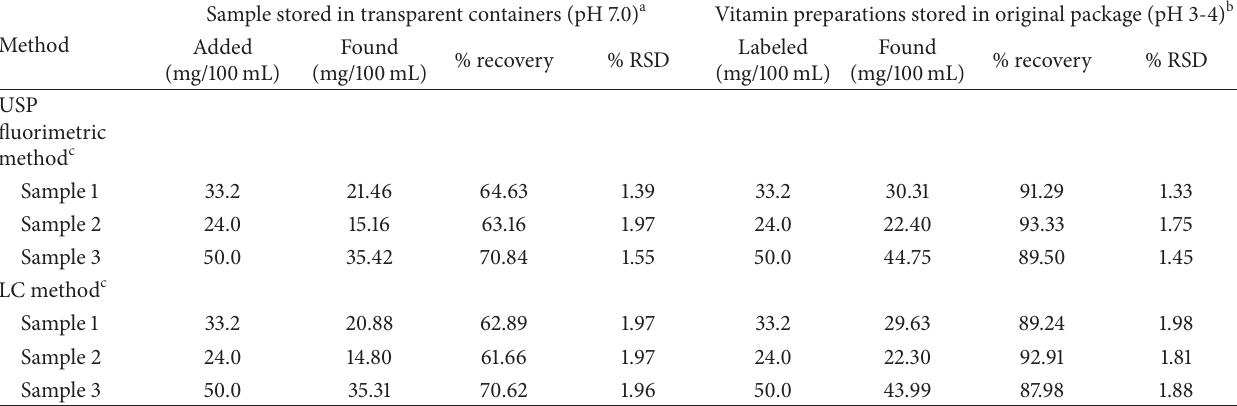
Table 4: Assay of RF in photodegraded samples and aged vitamin preparations (25 ± 1 ∘ C).